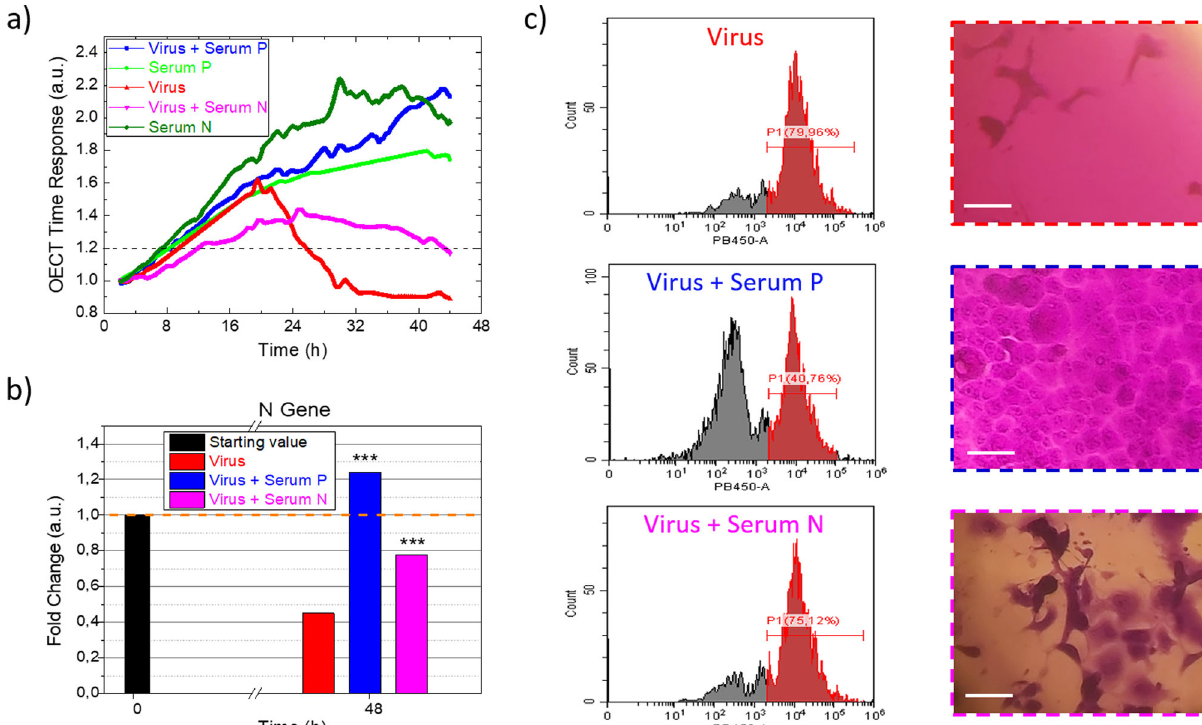
Fig. 2 OECT, PCR and Cyto fl uorimeter analysis on Sars-Cov-2 infected and healthy cells. a OECT real-time monitoring of SARS-Cov-2-infected cell lines (red), with neutralizing (blu) and non-neutralizing (magenta) antibodies and sera controls (light and dark green for neutralizing and non-neutralizing antibodies, respectively). The horizontal dashed black line is inserted as the threshold discriminating between viral-proliferating and healthy cell cultures. b Graph reporting qRT-PCR Allplex Seegene data normalized to the starting value at the beginning of each experiment. The orange dashed line is inserted to stress the difference between viral proliferating cultures, having reduced PRC value after 48 h, and viral-neutralized ones, with increasing PCR. *** p < 0.001 denote signi fi cant differences with respect to the “ Virus ” data (red column). c Cyto fl uorimeter analysis on cell population and optical micrographs on Crystal Violet stained cells of cell cultures for viral-infected cell lines (red), with neutralizing (blu) and non-neutralizing (magenta) antibodies. The black histogram corresponds to unstained healthy cells whereas the red histogram represents suffering cells characterized by membrane alterations that allow the DAPI to enter. White scale bars in the micrographs of 100 μ m.